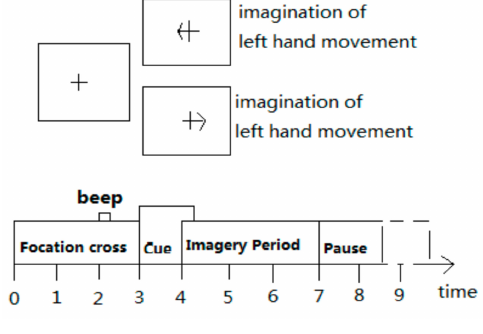
Figure 2. Experimental